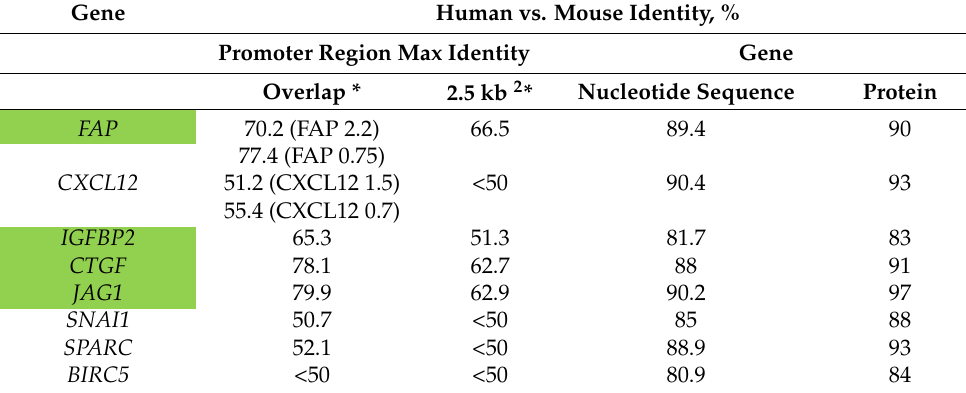
Table 1. The degree of identity for human and mouse homologous